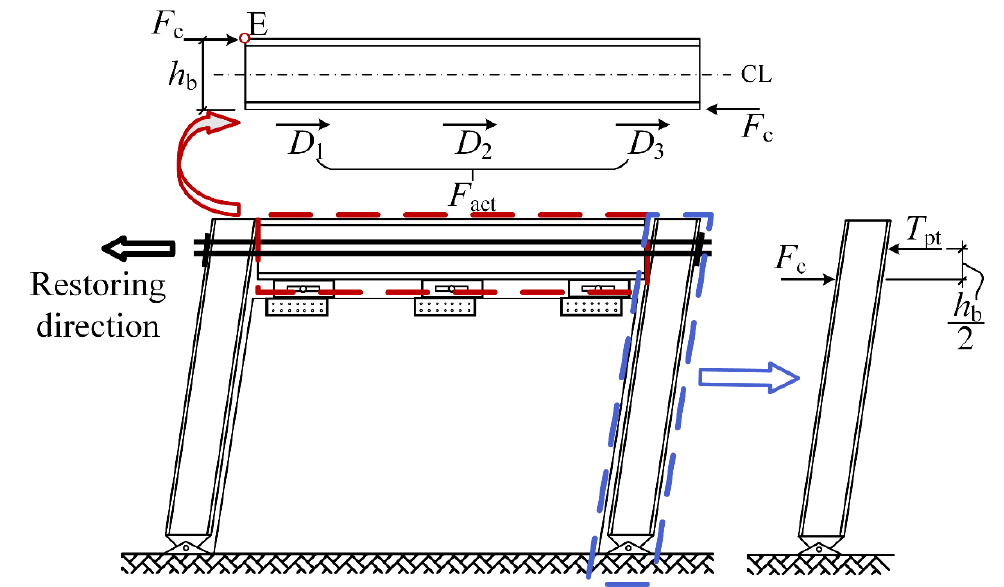
Figure 10. SC-STHSW system during the restoring process.